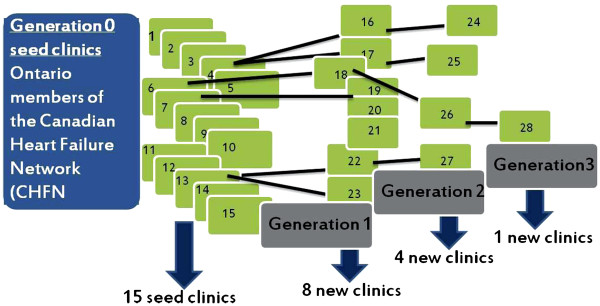
Process by which 28 clinics were identified by snowball sampling. Based on interview responses from the initial 15 seed clinics, full saturation was reached in 3 generations.